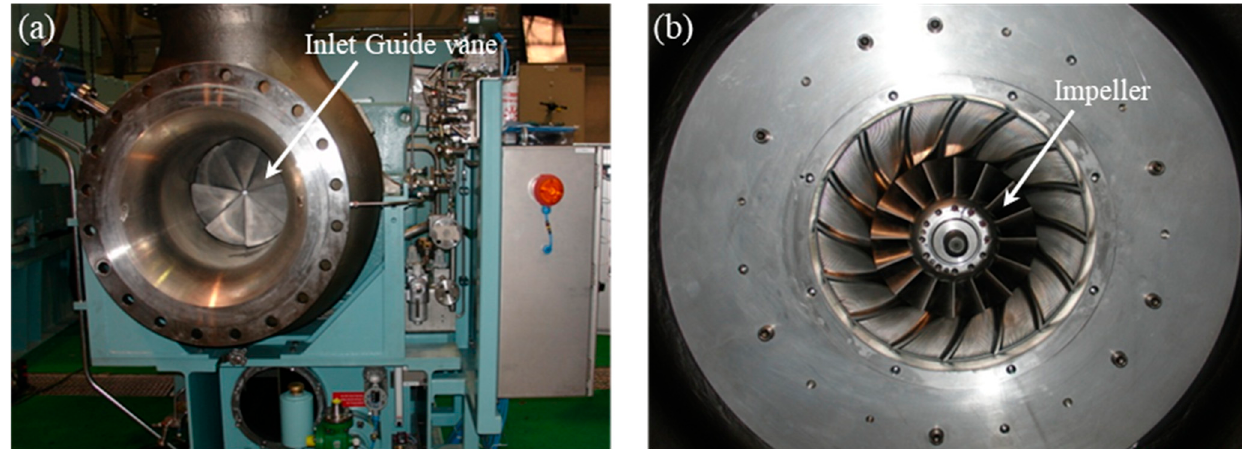
Figure 3. Photographs of ( a ) the inlet guide vane and ( b ) the impeller.